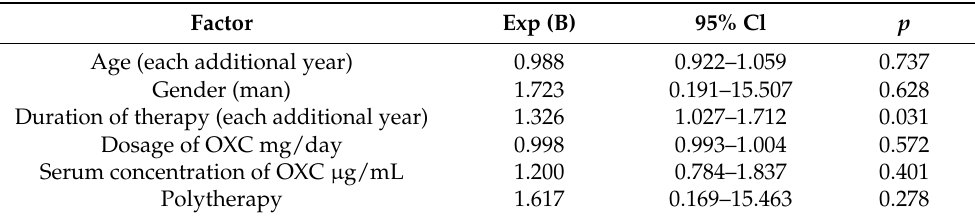
Table 5. Analysis of effective variables that lead to the development of hyponatremia among patients who take